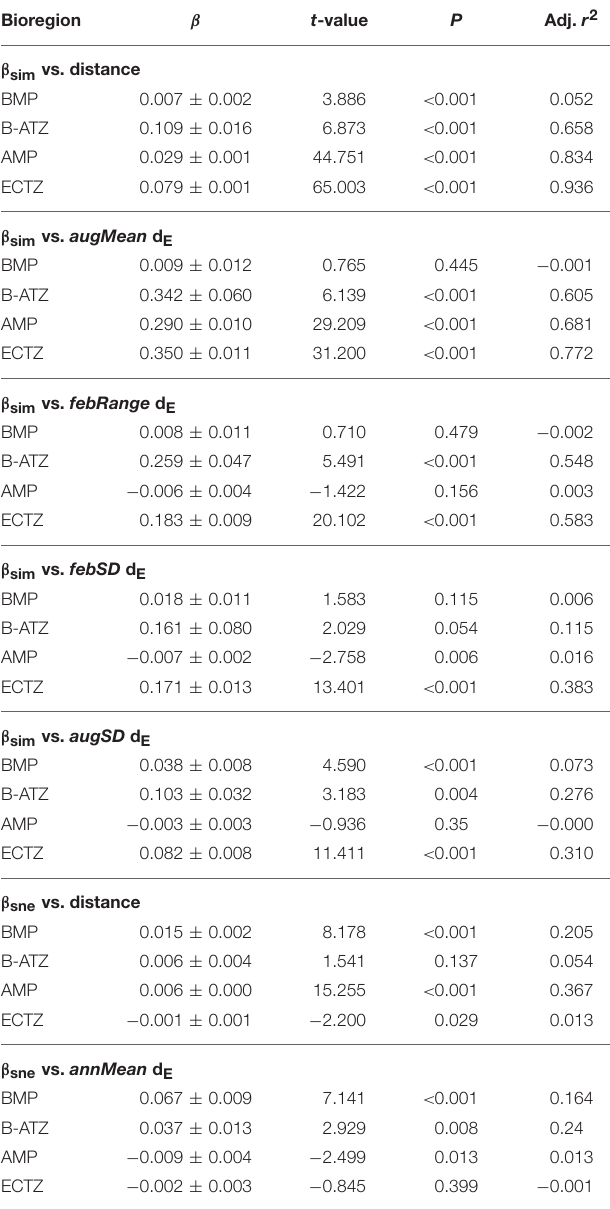
TABLE 3 | Linear regressions of pairwise β sim and β sne as a function of the geographical or thermal distance between the section pairs. Bioregion β t -value P Adj. r